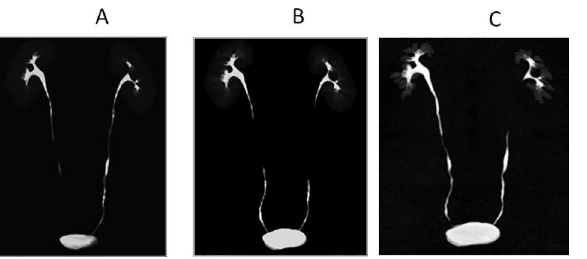
Fig 3. Maximum intensity projection images show the upper urinary tracts obtained in the three excretoryphases in a 44-year-old man. A, Excretory phase with a 5-minutedelay. B, Excretory phasewith a 10-minute delay. C, Excretory phase with a 15-minute delay. With a 5-minute delay, non-opacification was noted in the right ureter, but with a 10- or 15-minute delay, the non-opacified segmentswere delineated.On the other hand, just a 5-minutedelay was sufficient for completeopacification of the left ureter. The numbers of completelyopacifiedsegmentswere 5, 4, 6, 6, 7, 7, and 8 with the 5-, 10-, 15-, 5 + 10-, 5 + 15-, 10 + 15-, and 5 + 10 + 15-minutedelays, respectively. Multi-phasic acquisitionwas thus able to delineate more segments.